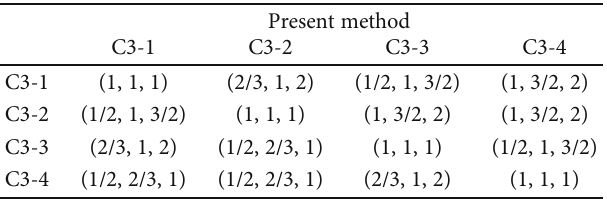
Table 9: The comparison matrix with respect to the atmospheric environment.